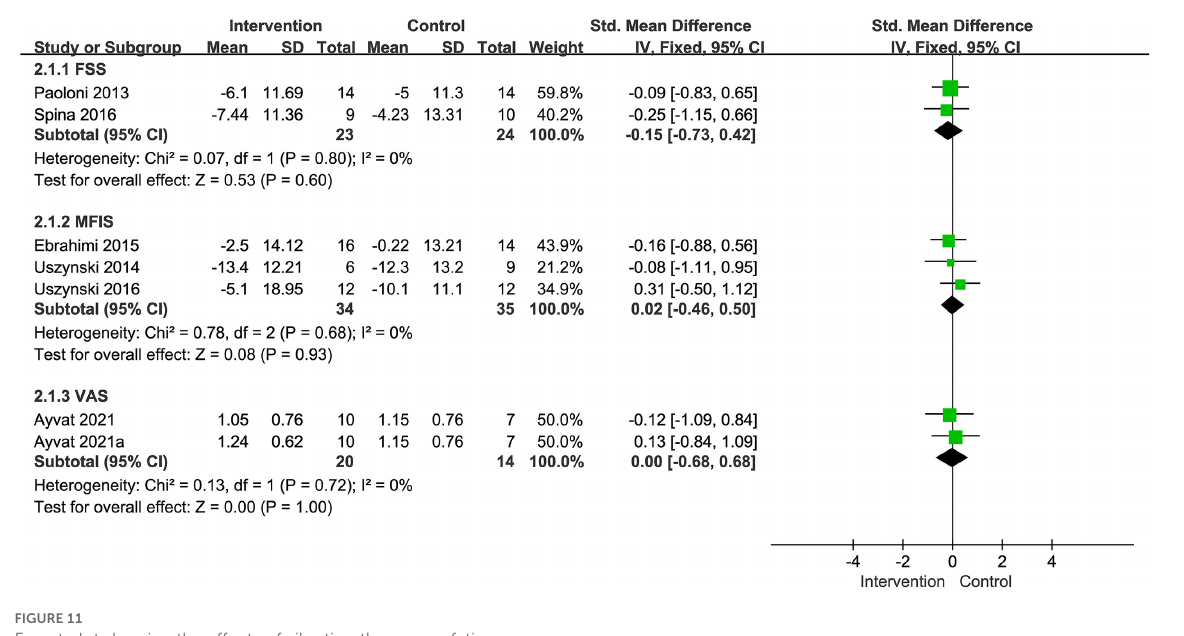
FIGURE11 Forest plot showing the effects of vibration therapy on